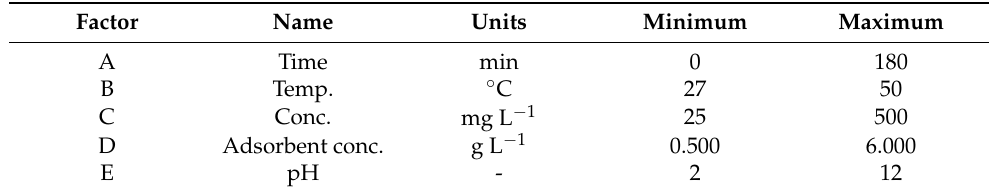
Table 1. Experimental span for influencing factors [1] (Reproduction with permission from the publisher).